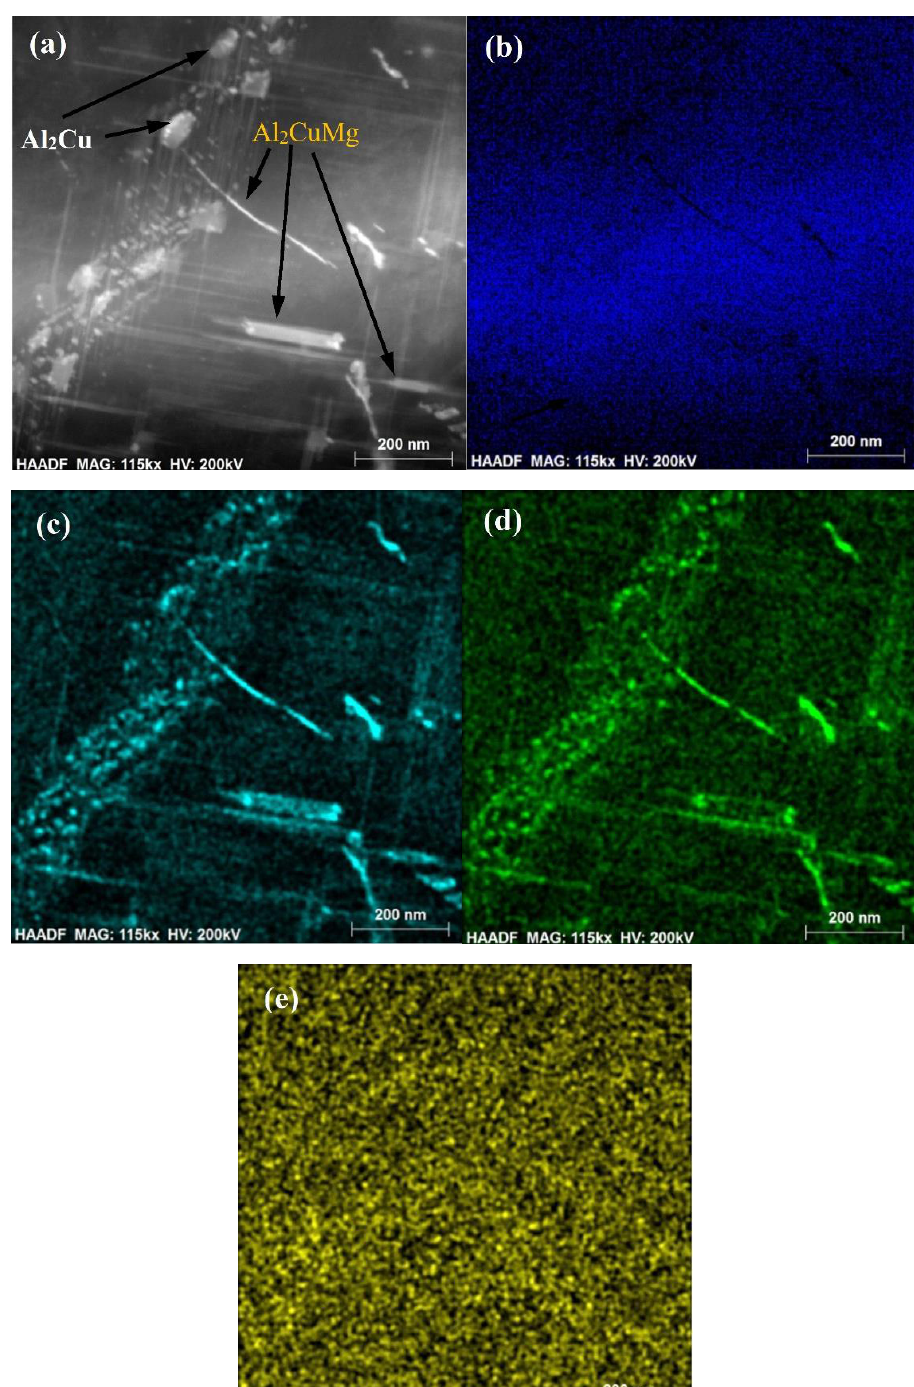
Figure 18. TEM and EDX of rheoformed 2024 aluminum matrix composite component reinforced by 5 vol % Al 2 O 3 nanoparticles at 620 °C after T6 heat treatment ( a ) TEM image; ( b ) Al; ( c ) Cu; ( d ) Mg; ( e ) 5 vol % Al 2 O 3 nanoparticles at 620 ◦ C after T6 heat treatment ( a ) TEM image; ( b ) Al; ( c ) Cu; ( d ) Mg; ( e ) O.